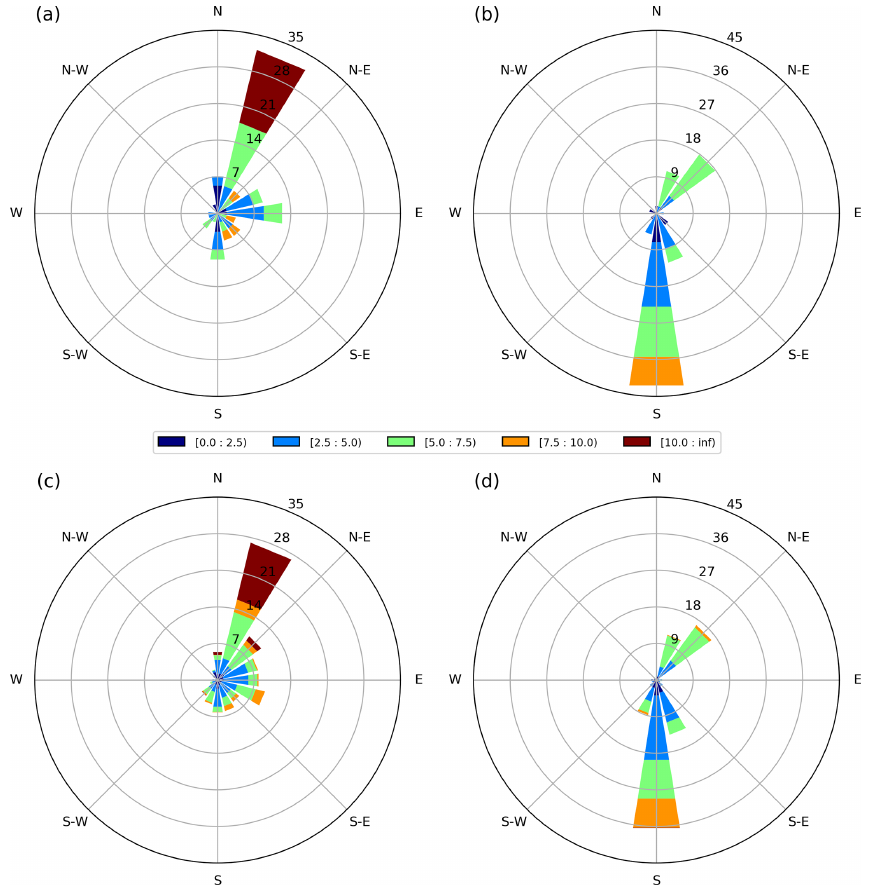
Figure 3. Wind roses of velocity and direction at Kafireas Strait for the 7d deterministic simulations during (a) winter and (b) spring; (c–d) same as (a) and (b) , but for the 50 ensemble members. Colors in units (m/s) and isocontours